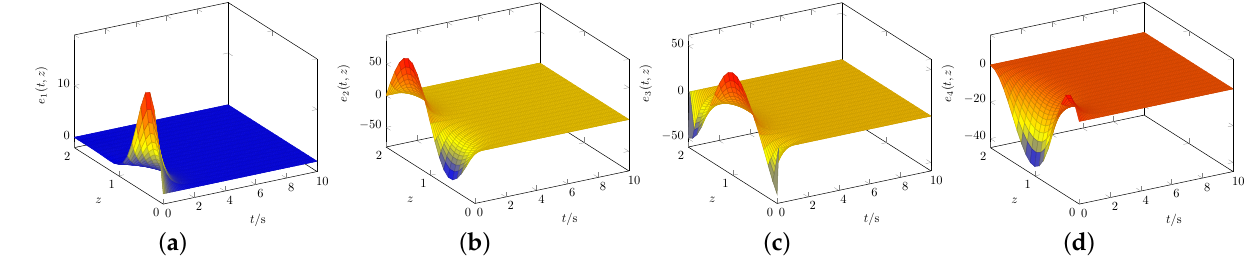
Figure 2. The spatial states of four estimators. ( a ) Spatial state of estimator 1. ( b ) Spatial state of estimator 2. ( c ) Spatial state of estimator 3. ( d ) Spatial state of estimator 4.